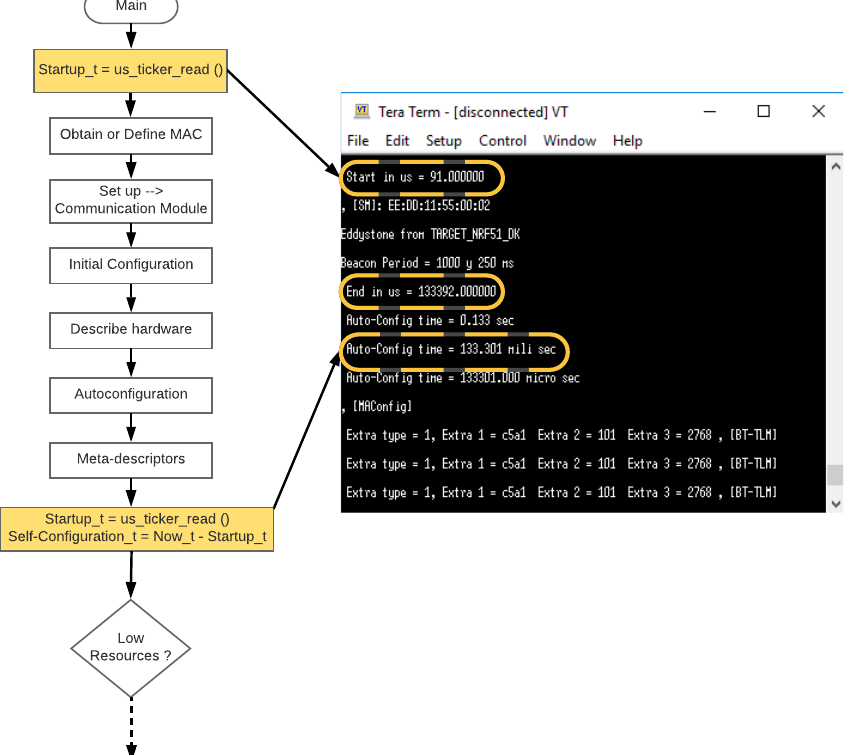
Figure 28. Calculation of the self-configuration